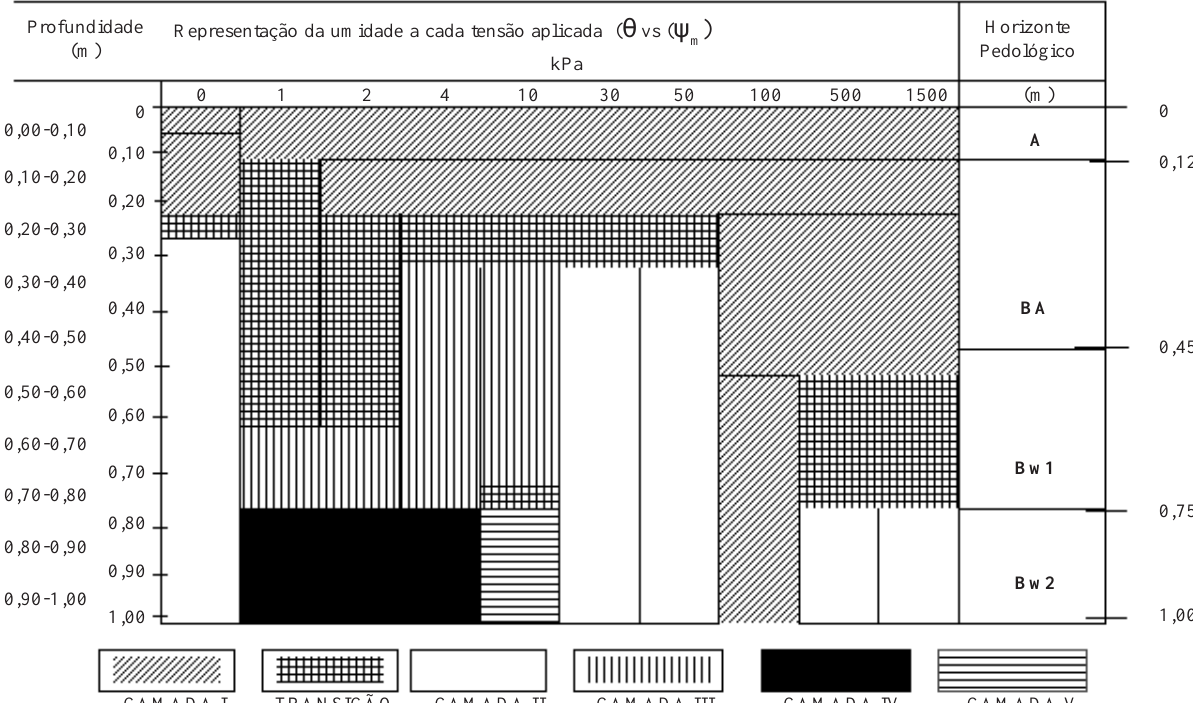
Figura 3. Diagrama comparativo entre horizontes hidráulicos e pedológicos identificados no Latossolo Amarelo